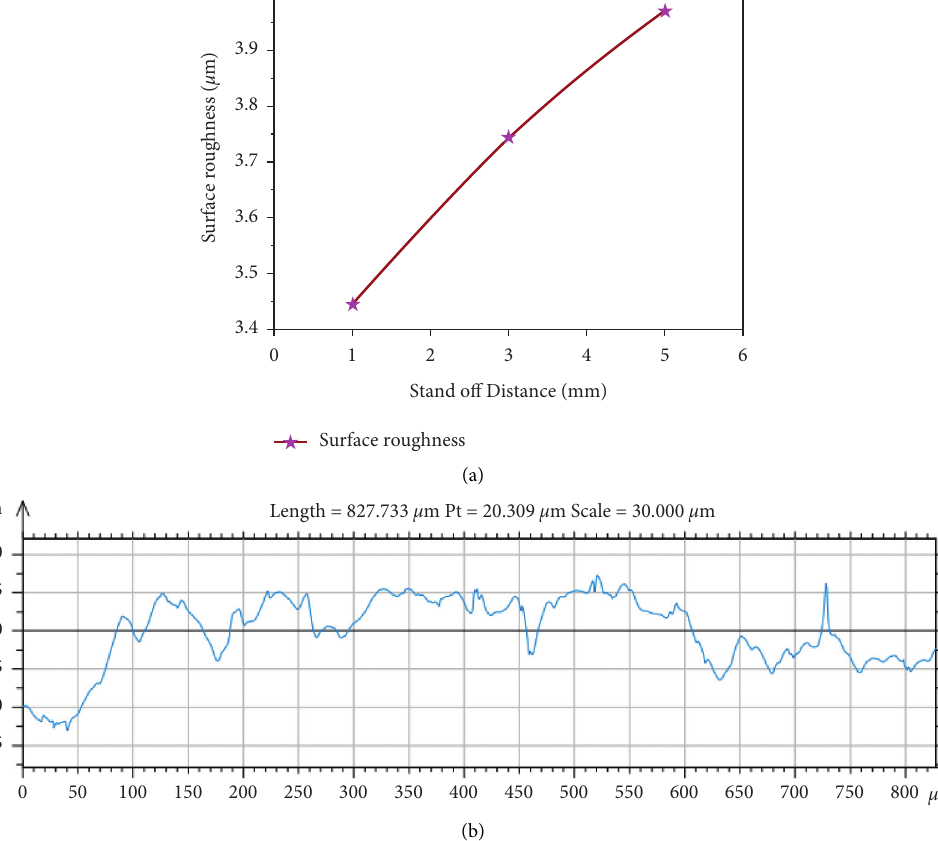
Figure 5: (a) Effect of standoff distance concerning surface roughness.(b)Surface roughness profile of the optimized condition for the recovered fiber backing.Performance analysis of reused fiber backing in coated abrasive application